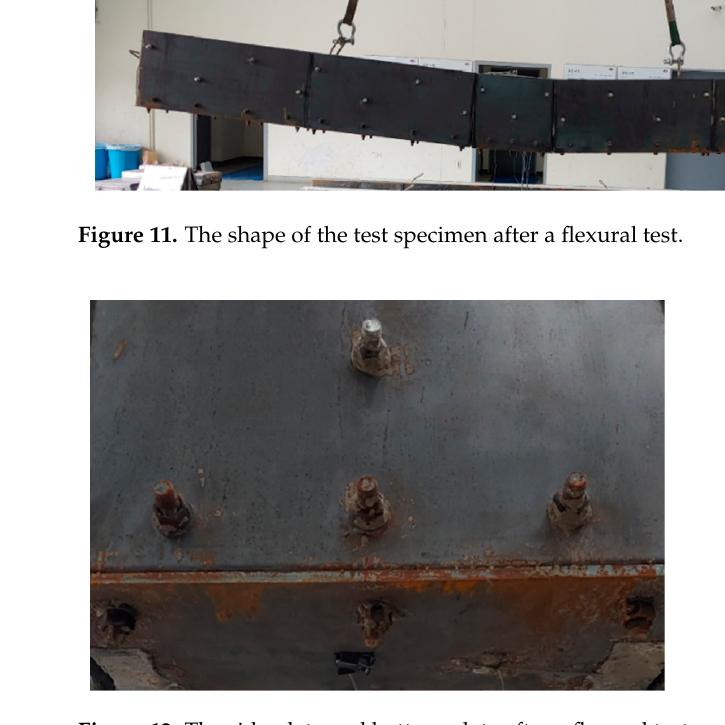
Figure 12. The side plate and bottom plate after a flexural test.